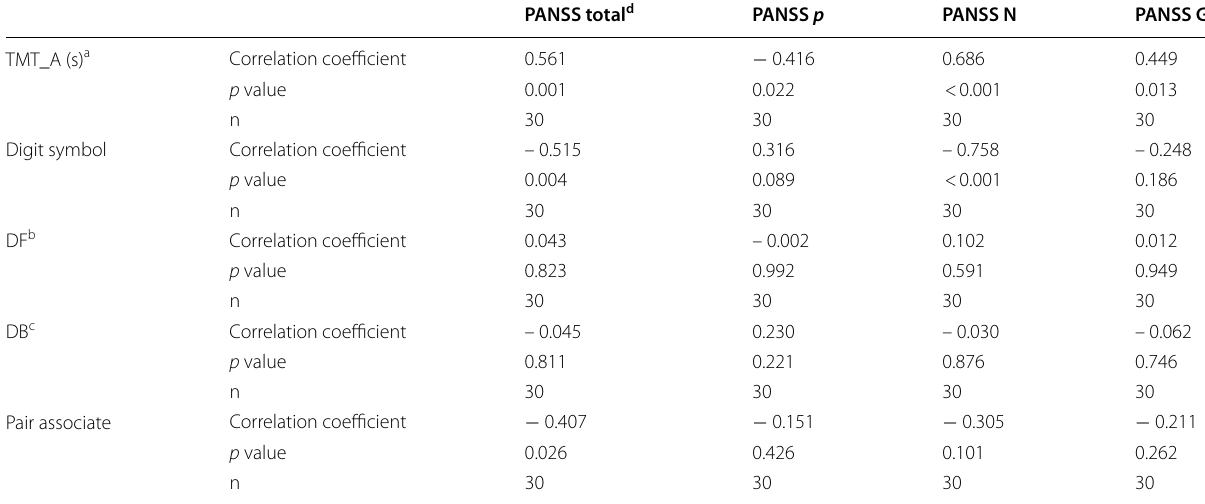
Table 7 Correlation results of PANNS scores and basic cognitive